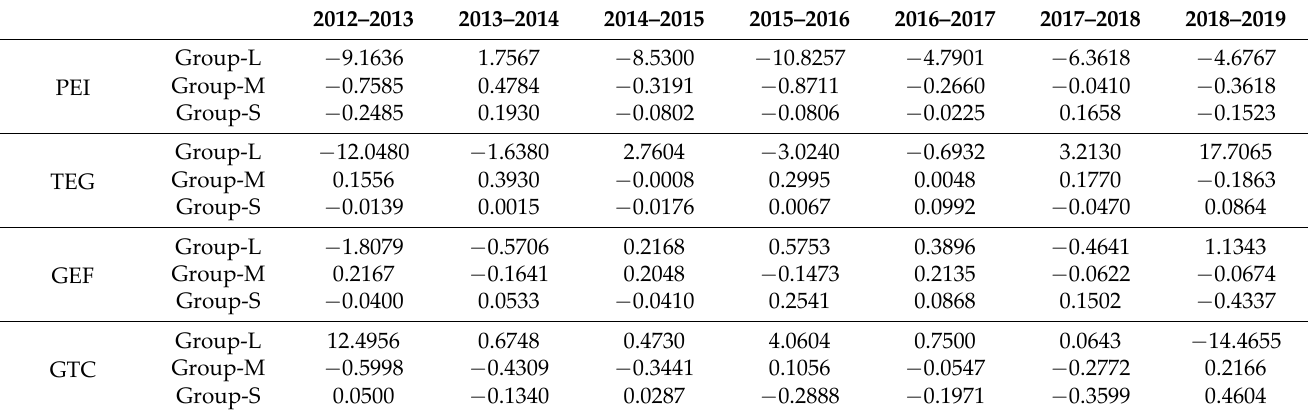
Table 4. Single‑period attribution results leads to different groups (Unit: